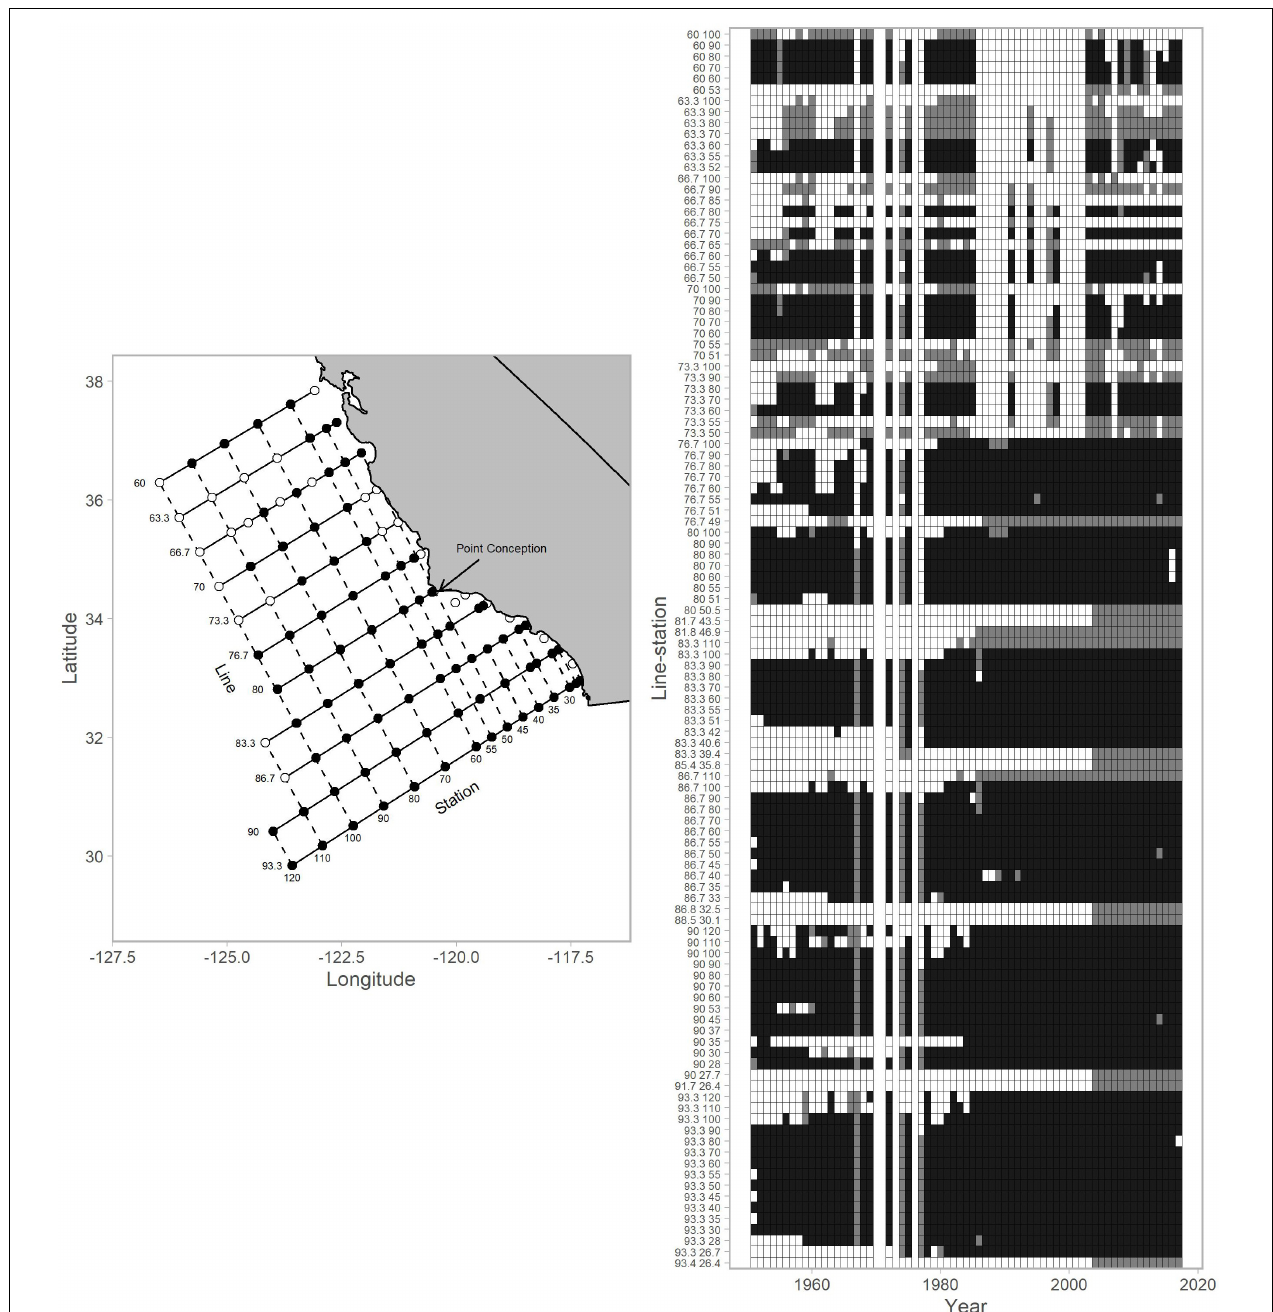
FIGURE 1 | Map of stations within the CalCOFI survey grid and the data availabilities for each individual station (referenced by line-station) for 1951–2017. The map (left column) shows stations used for this analysis (black points) and those that were not (white points). The arrow indicates the location of Point Conception. The data availability plot (right column) shows survey records for years with winter-spring values (black tiles), summer-autumn values (gray tiles; not used in analysis), and no coverage (white tiles). CalCOFI shifted from annual to mostly triennial sampling from 1971–1983 resulting in no surveys in some years. In the early years of CalCOFI, the survey area extended north to British Columbia, Canada and south to Baja California, Mexico (not